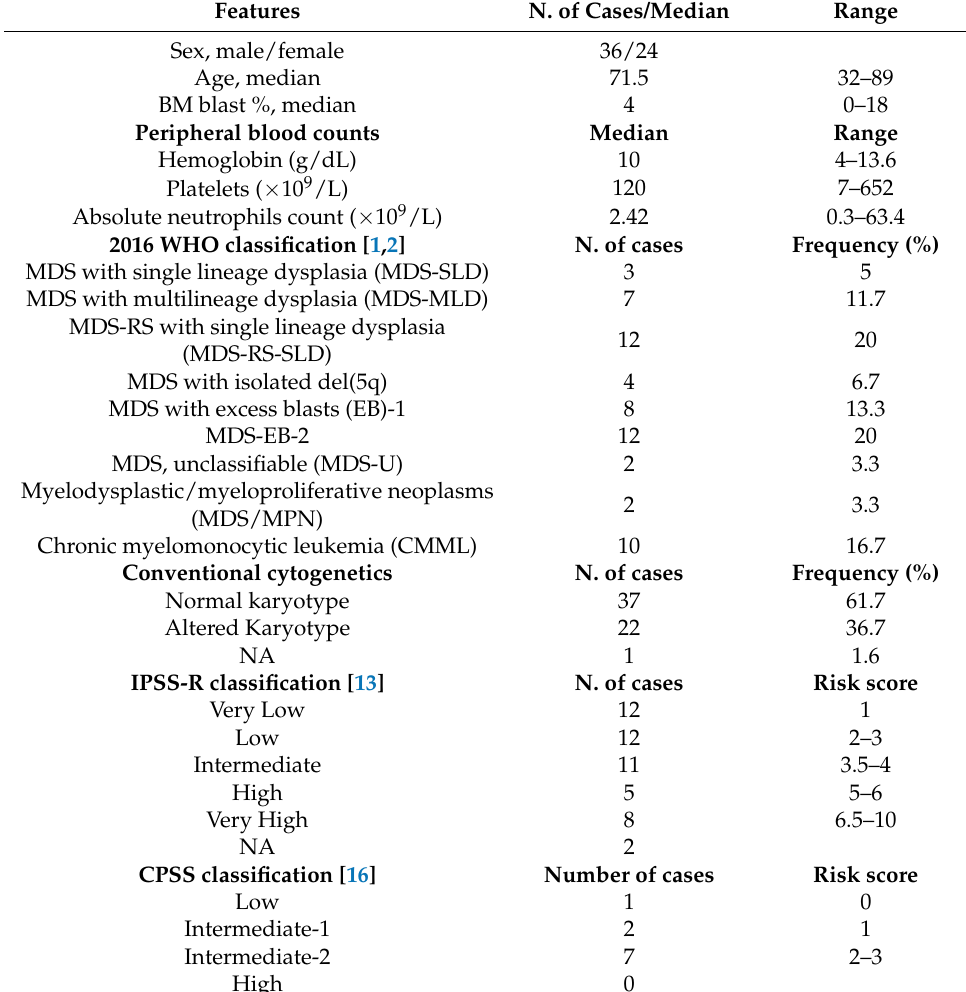
Table 1. Clinical variables of patients included in the study.